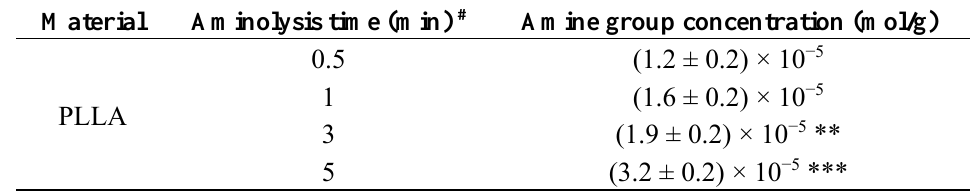
Table 2. Total amine group concentration (mol/g) inserted into PLLA scaffolds as a function of reaction time